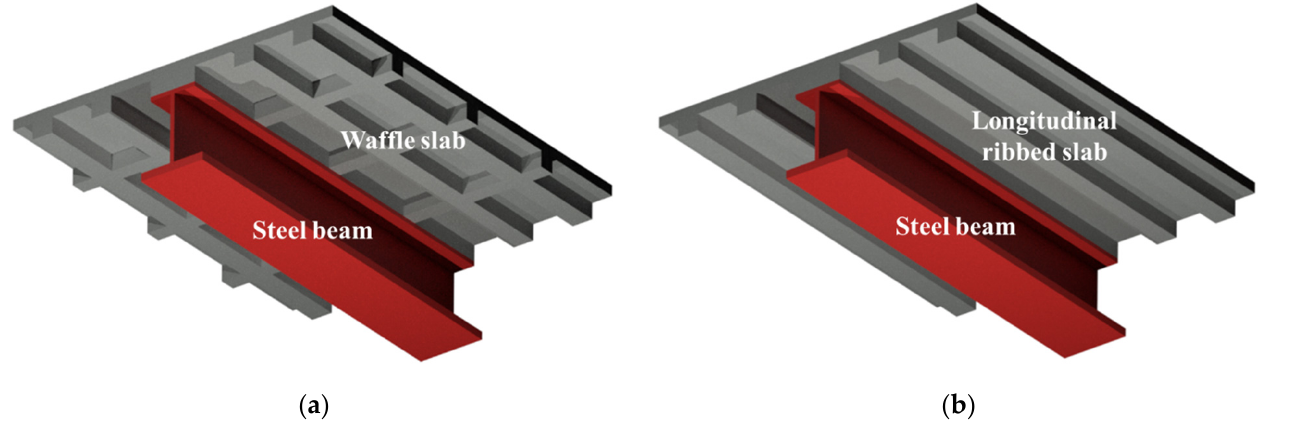
Figure 1. The SU-RSCS: ( a ) SU-WSCS; ( b ) SU-LRSCS. SU-WSCS is taken as an example to establish the theoretical calculation model for considering the shear-lag effect. As shown in Figure 2, the height of the steel beam is h s , of which the width and thickness of the upper flange are b st and h st , respectively, and those of the lower flange are b sb and h sb , respectively. The steel web height is h w and the thickness is b w . The width of the UHPC slab is b with the thickness of h c , where the thin plate has a thickness of h cp-w and the ribs have a height of h cr-w . b 1 ~ b 4 denotes the width of the longitudinal ribs and their clear spacings, as shown in Figure 2b. The width of the transverse ribs is b w , and the total number of that is n w .